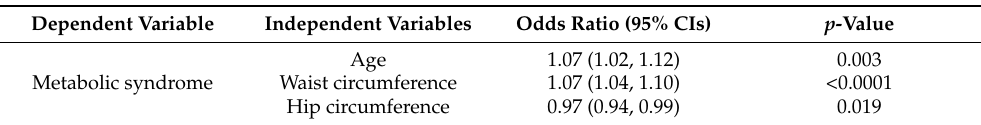
Table 4. A multivariable logistic regression model illustrating the relationship between waist and hip circumferences and metabolic syndrome (without